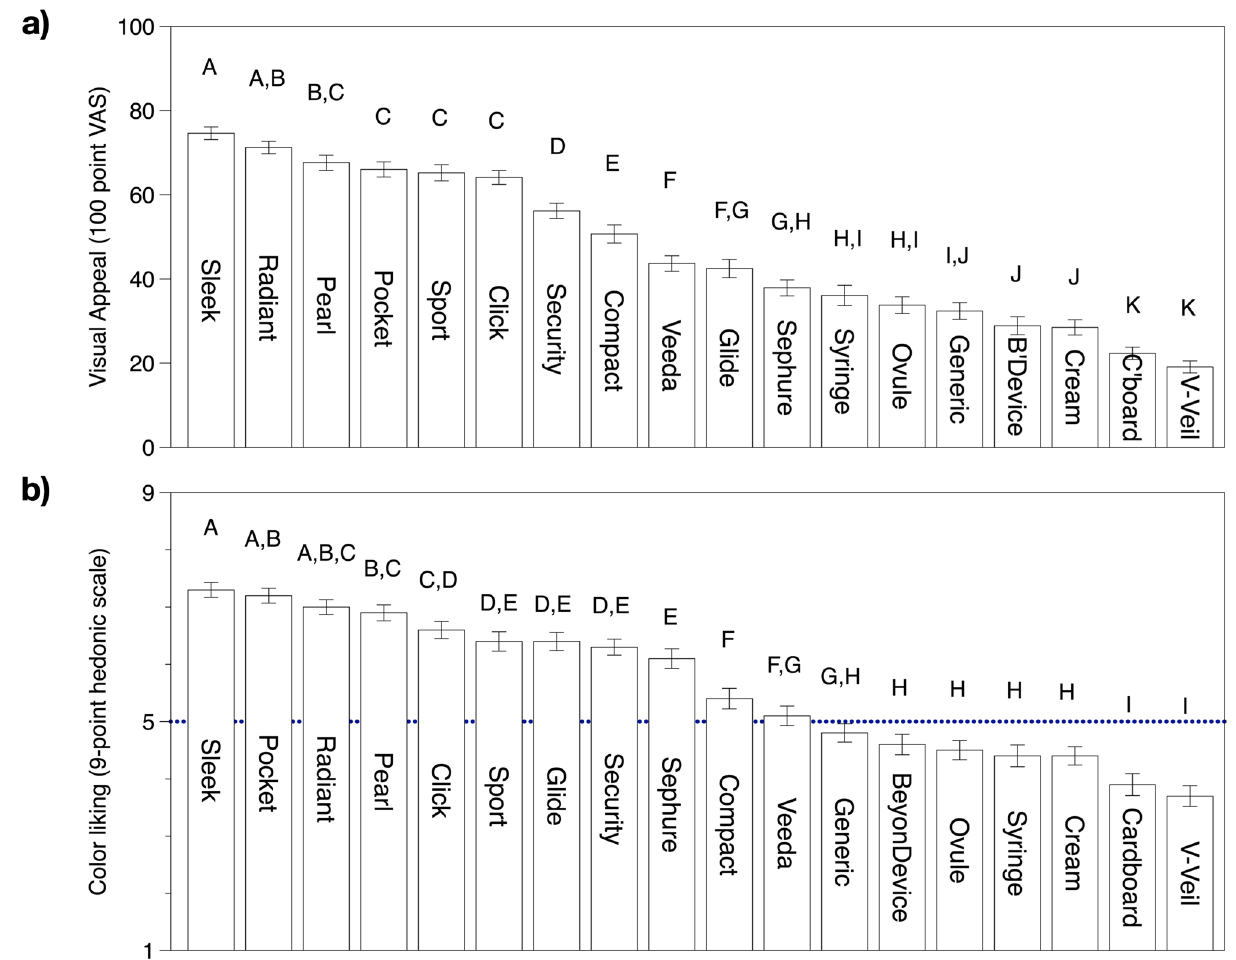
Figure 6. Means and standard errors for ( a ) visual appeal (VAS rating) and ( b ) color liking (9 pt hedonic scale). Short applicator names correspond to Fig. 1. Ratings for visual appeal were collected on a 100-point VAS where verbal anchors were placed at 10 (Not at all appealing) and 90 (Very appealing); a midpoint was not provided. Coloring liking was obtained with a 9-point hedonic scale where 1 = Dislike extremely and 9 = Like extremely. Within a panel, mean ratings with a letter in common are not significantly different at α = 0.05 (Fisher’s